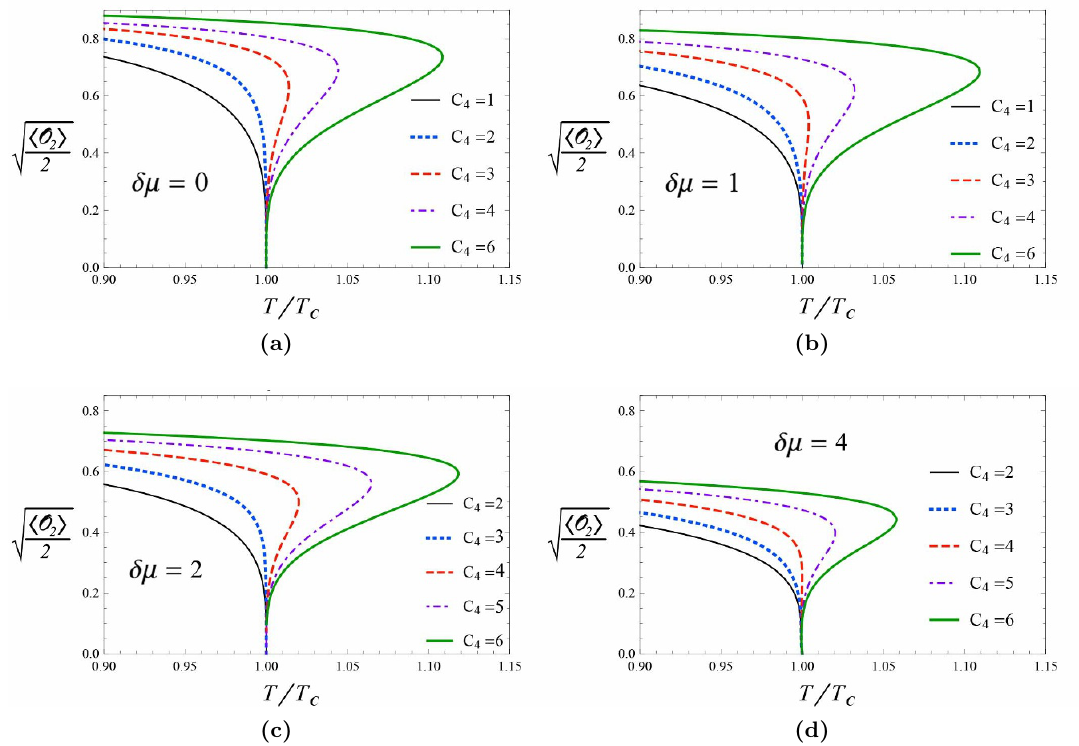
Figure 3. Condensation versus temperature normalized by T c for chosen function F ( )= 2 + C 4 4